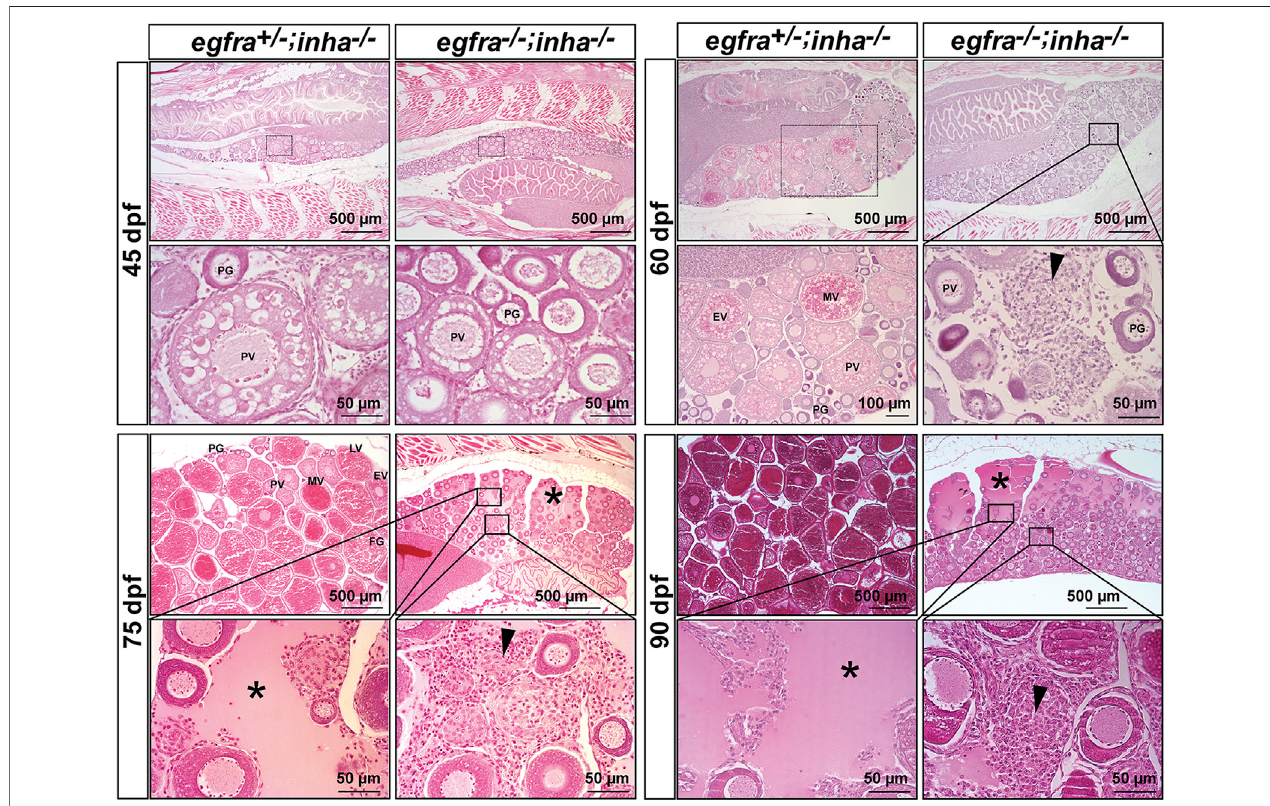
FIGURE 11 | Double mutant of egfra and inha ( egfra − / − ; inha − / − ) induced ovarian fi brosis and hydrovarium. The egfra +/ − and inha − /- females were used as the control. Follicles were undergoing PG-PV transition at 45 dpf in both control and double mutant. These follicles continued to grow in the control ovary at 60 dpf with signi fi cantyolkaccumulationinleadingoocytes;however,thegrowthstoppedcompletelyatPGandearlyPVstagesinthedoublemutantovary( egfra − / − ; inha − / − ),which also showed fi brosis andaccumulationofsomaticstromalcellsbetweenfollicles.Theovarian lamellae startedtoexhibithydrovariuminthedorsalparts at75 dpf in the double mutant, and the amount of fl uid (asterisk) and fi brosis (arrowhead) continued to increase at 90 dpf. PG, primary growth; PV, previtellogenic; EV, early